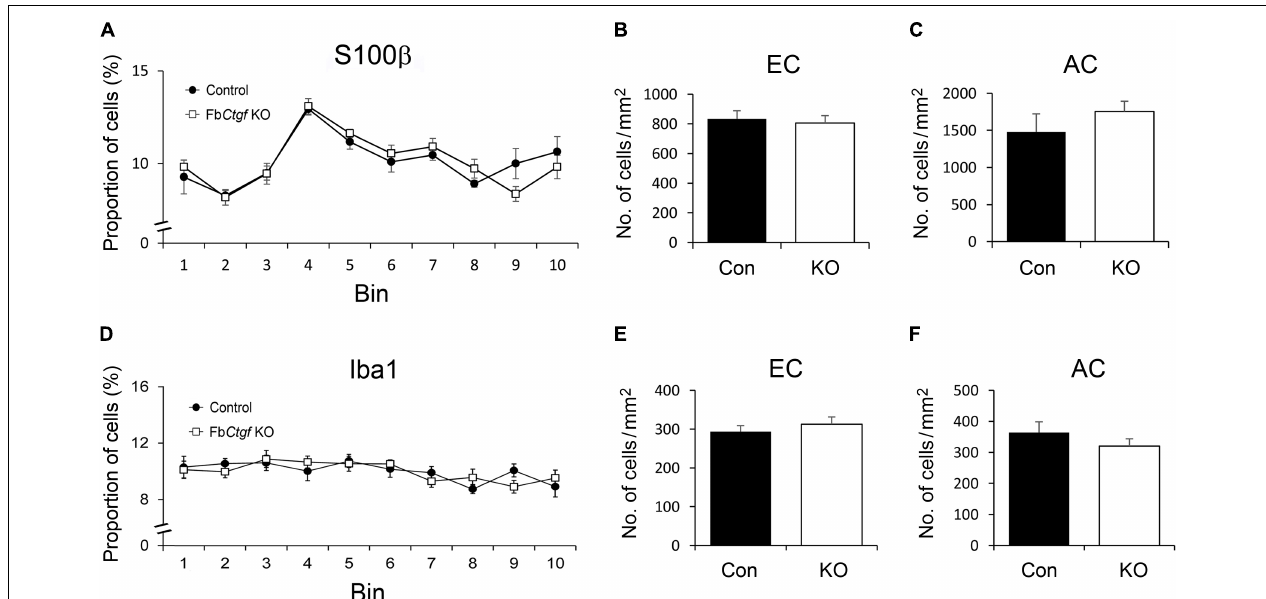
FIGURE 6 | Distributions of astrocytes and microglia in the brain. In the somatosensory cortex, the distribution of S100b-positive astrocytes and Iba1-positive microglia was measured using 10 counting bins of 100 µ m from the pia surface to the edge of the white matter. In this counting system, the distributions of astrocytes were similar between control and Fb Ctgf KO mice (A) . The densities of astrocytes were comparable between genotypes in both EC (B) and AC (C) . Iba1-positive microglia were evenly distributed in the cortex of both genotypes (D) . The densities of microglia were similar between control and Fb Ctgf KO mice in both EC (E) and AC (F) . n = 5 in each genotype. Results are means ± SEM.